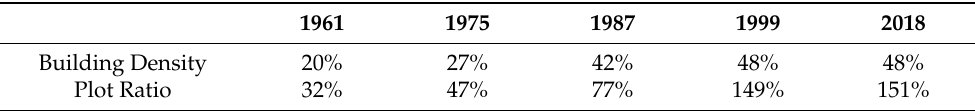
Table 3. Building density and plot ratio of AMS compound.